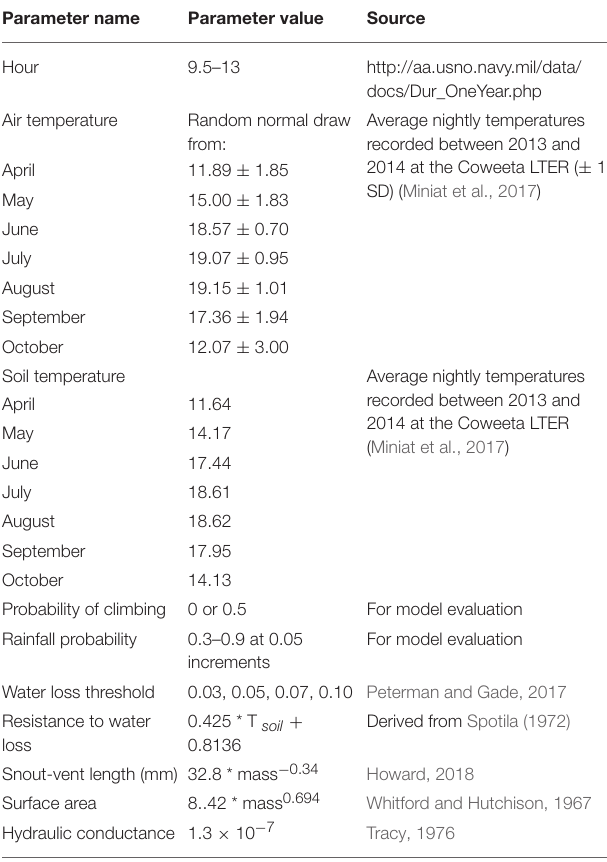
TABLE 1 | Simulated abiotic factors, and biophysical parameters and functions used in the